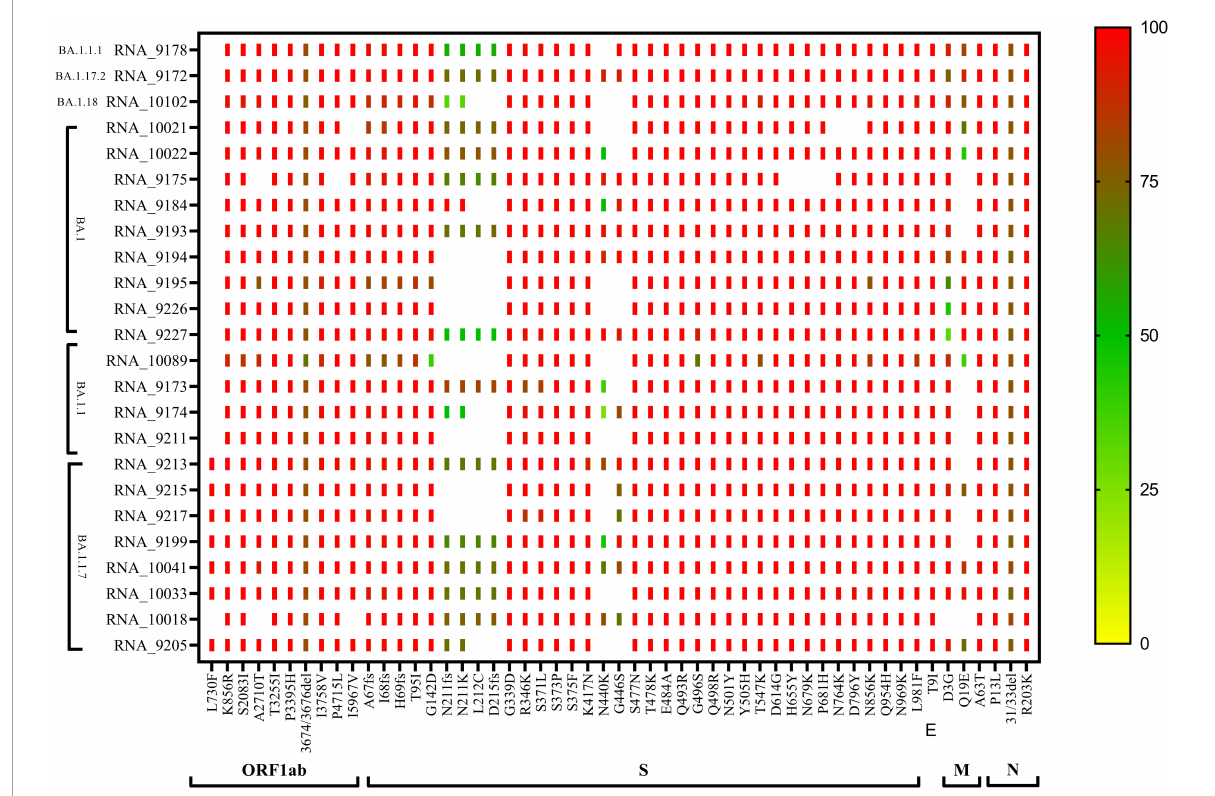
FIGURE2 CLC genomics analysis of the mutational changes in the BA.1 and sub-lineages of the Omicron variant. The scale representing the frequency of residue changes from least (Blue) to highest (Red) . S, spike protein; E, envelope protein; M, membrane protein; N, nucleocapsid protein.